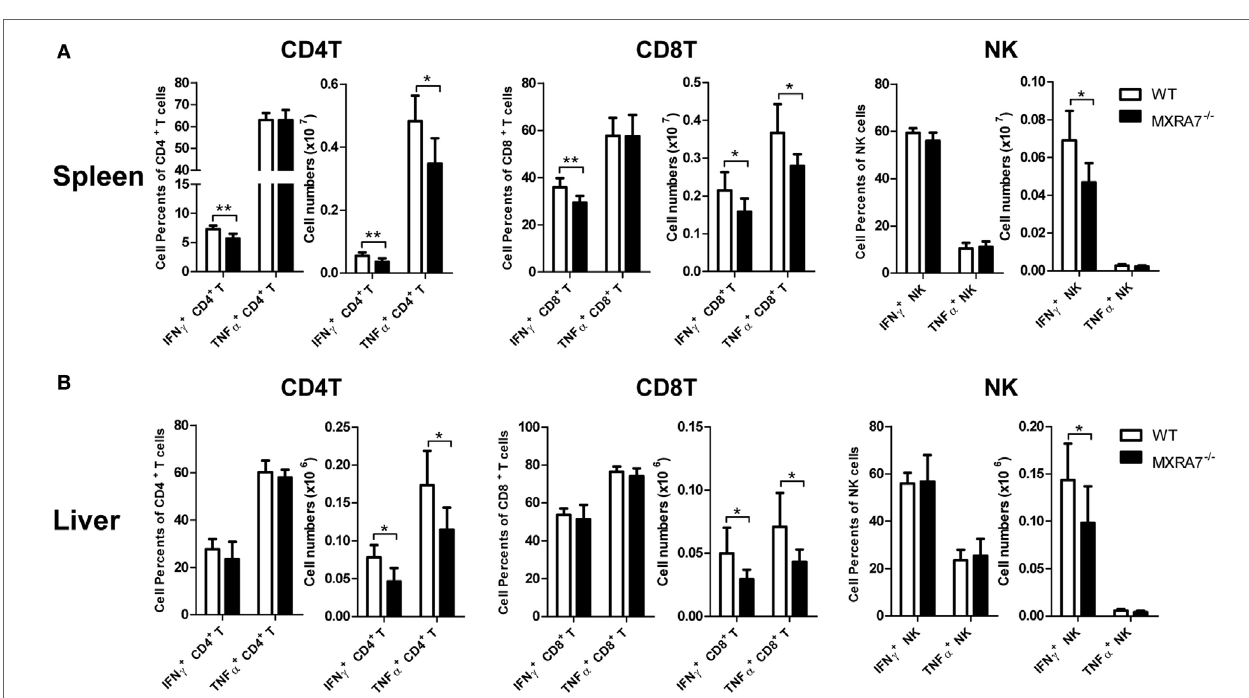
FigUre 4 | Matrix remodeling associated 7 (MXRA7) deficiency inhibits IFN γ and TNF α production in T cells. Twenty four hours after 1 ml/kg CCl 4 injection, mice from different groups ( n = 7 each group) were sacrificed. Splenocytes (a) and intrahepatic leukocytes (B) were isolated, stimulated, and stained for intracellular cytokines in combination with cell surface staining. The percentages of IFN γ + in CD4 + T and CD8 + T cells were decreased in MXRA7 − / − spleens. The numbers of IFN γ + and TNF α + in CD4 + T and CD8 + T cells were decreased in both spleens and livers of MXRA7 − / − mice. Data shown are the representative of three independent experiments. * p < 0.05, ** p <